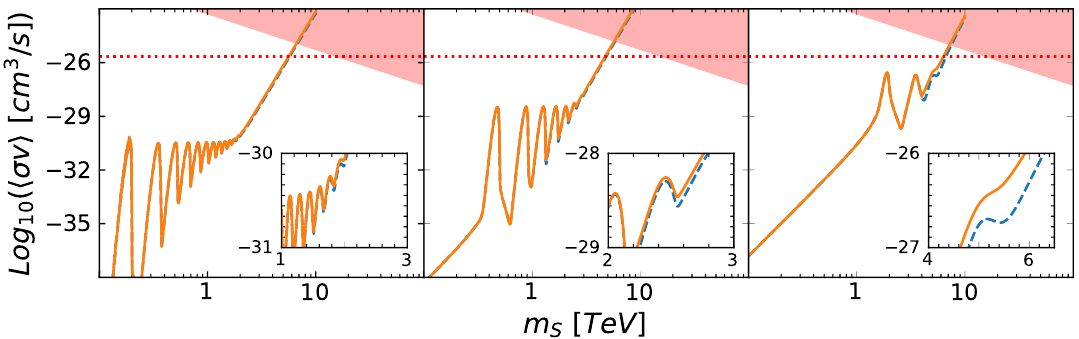
Figure 3 . The thermally-averaged scalar DM annihilation cross-section through virtual KK- graviton exchange and direct production of two KK-gravitons, (cid:27) G = (cid:27) ve ;G + (cid:27) GG , as a function of the DM mass m S . In all panels, the solid orange (blue dashed) lines represent the total cross-section including (not including) mixed KK-graviton production and diagram (c) contribution. The latter case corresponds to refs. [18] and [21]. In order to appreciate the di(cid:11)erence, we have included in all panels a zoomed plot in linear scale for the range of m S of interest. Left panel: (cid:3) = 1000